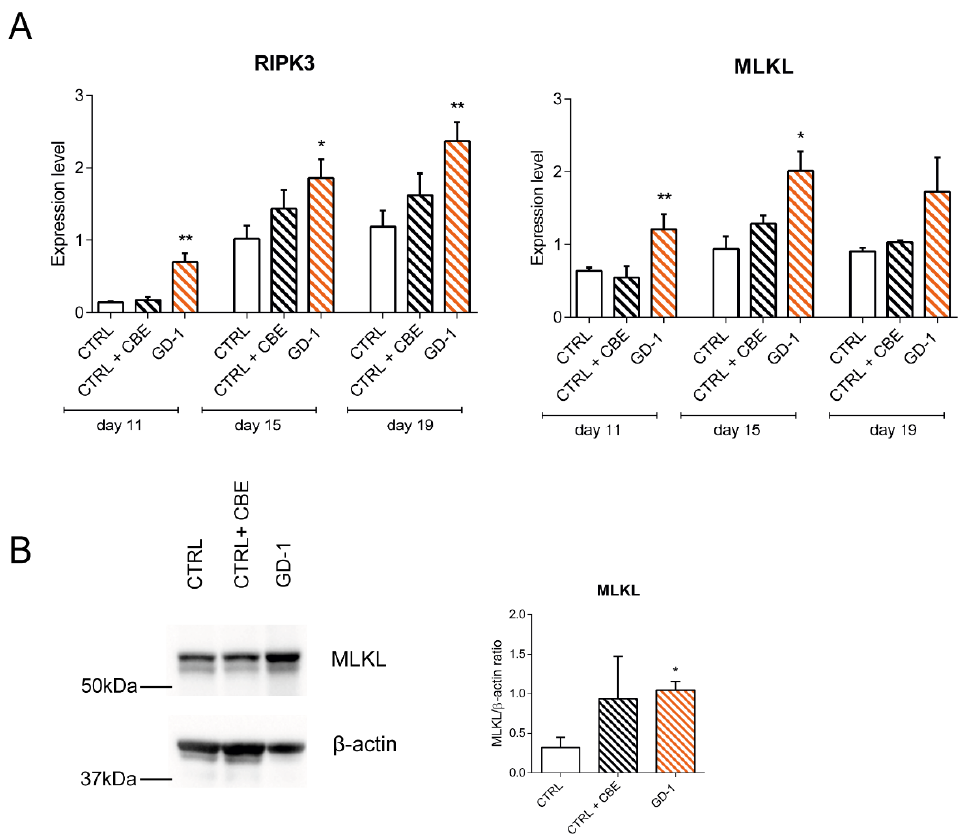
Figure 3. RIPK3 and MLKL are upregulated in GD iPSC-derived monocyte/macrophages. ( A ) Expression levels of RIPK3 and MLKL genes in iPSC-derived CTRL and GD lines at different time points during macrophage differentiation (day 11, 15 and 19). Expression levels are normalized with respect to three housekeeping genes. Graphs represent mean with SEM, n = 3. ( B ) Protein level of MLKL with the relative quantification, n = 2. Statistical significance is indicated (Student’s t -test), * p < 0.05, ** p < 0.01.